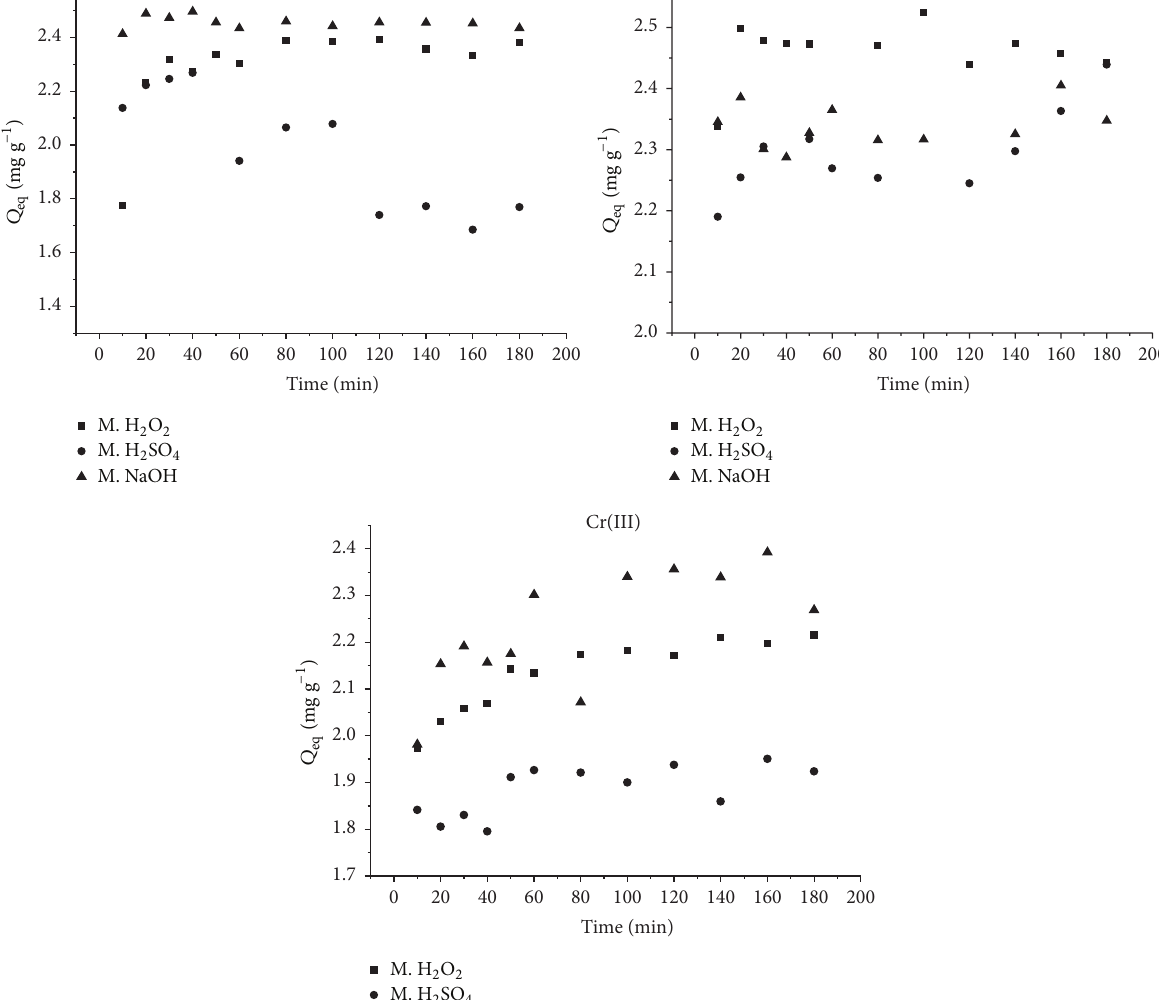
and Cr(III) in current study. This is due to 𝑅 2 rates being close to 1.0, indicating good mathematical adjustment, as noted in the following modified adsorbents: M. H 2 O 2 , M. H 2 SO 4 , and M. NaOH in adsorption of Cd(II); M. H 2 O 2 and M. NaOH in adsorption of Pb(II); and M. H 2 O 2 and M. H 2 SO 4 in adsorption of